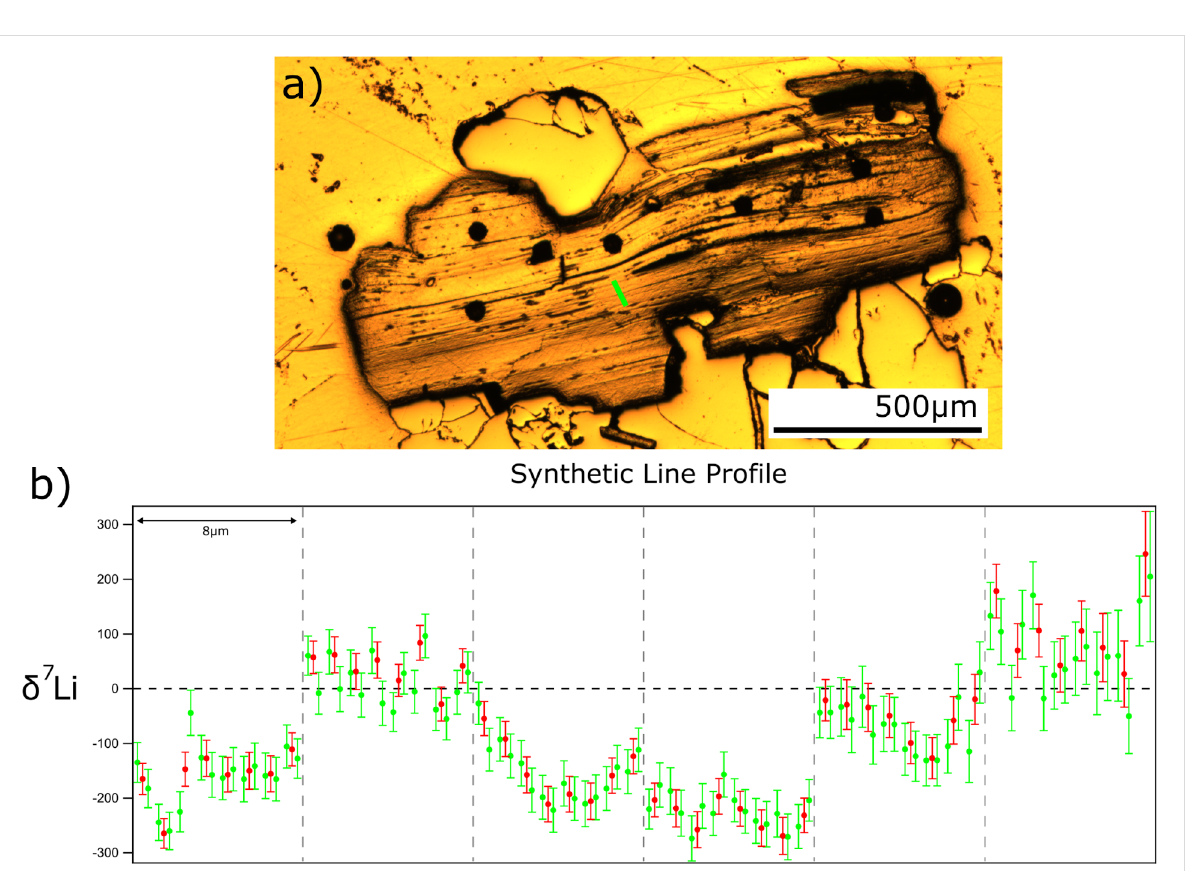
Figure 10: a) Examples of deformed cleavage planes in a Li-rich biotite mica shown parallel to the c -axis and b) δ 7 Li values for vertical strips taken perpendicular to the scanning direction of the beam, along the green line in a). Each vertical grey line represents two microns of space left between each image, whilst red values are calculated using 1/8th width strips of the original maps and green values are calculated using 1/16th strips. Values are normalised to the average ratio across all measurements of the sample, rather than to an external